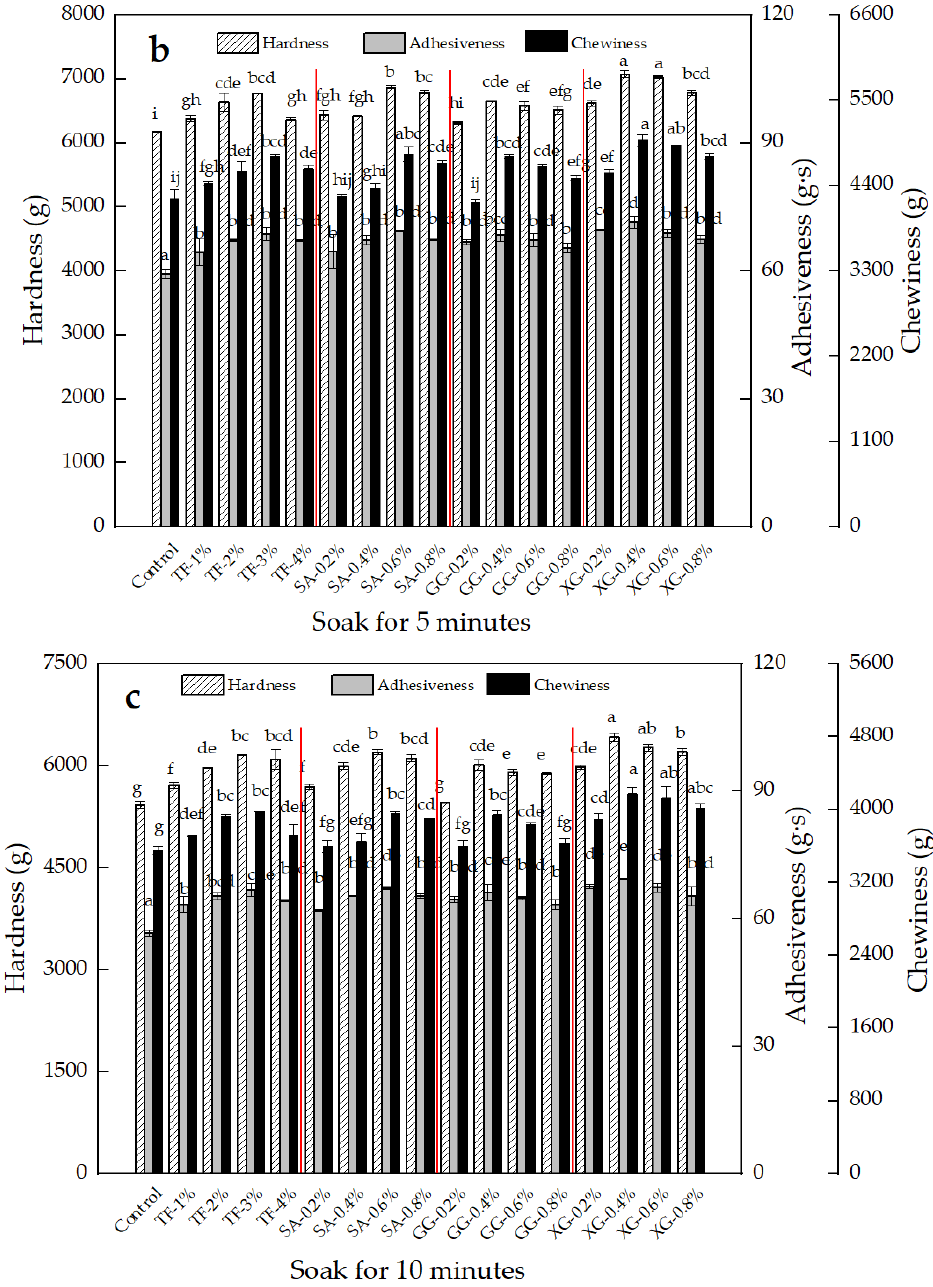
Figure 1. Effect of TF, SA, GG and XG on the textural properties of fresh noodles (( a ): noodles soaked for 0 min after cooking, ( b ): noodles soaked for 5 min after cooking, ( c ): noodles soaked for 10 min after cooking). Note: All experiments were carried out in triplicate according to independent replicate experiments, and the results were reported as mean value ± standard deviation. Values with the same superscript letters in in different figures are not significantly different at p < 0.05.